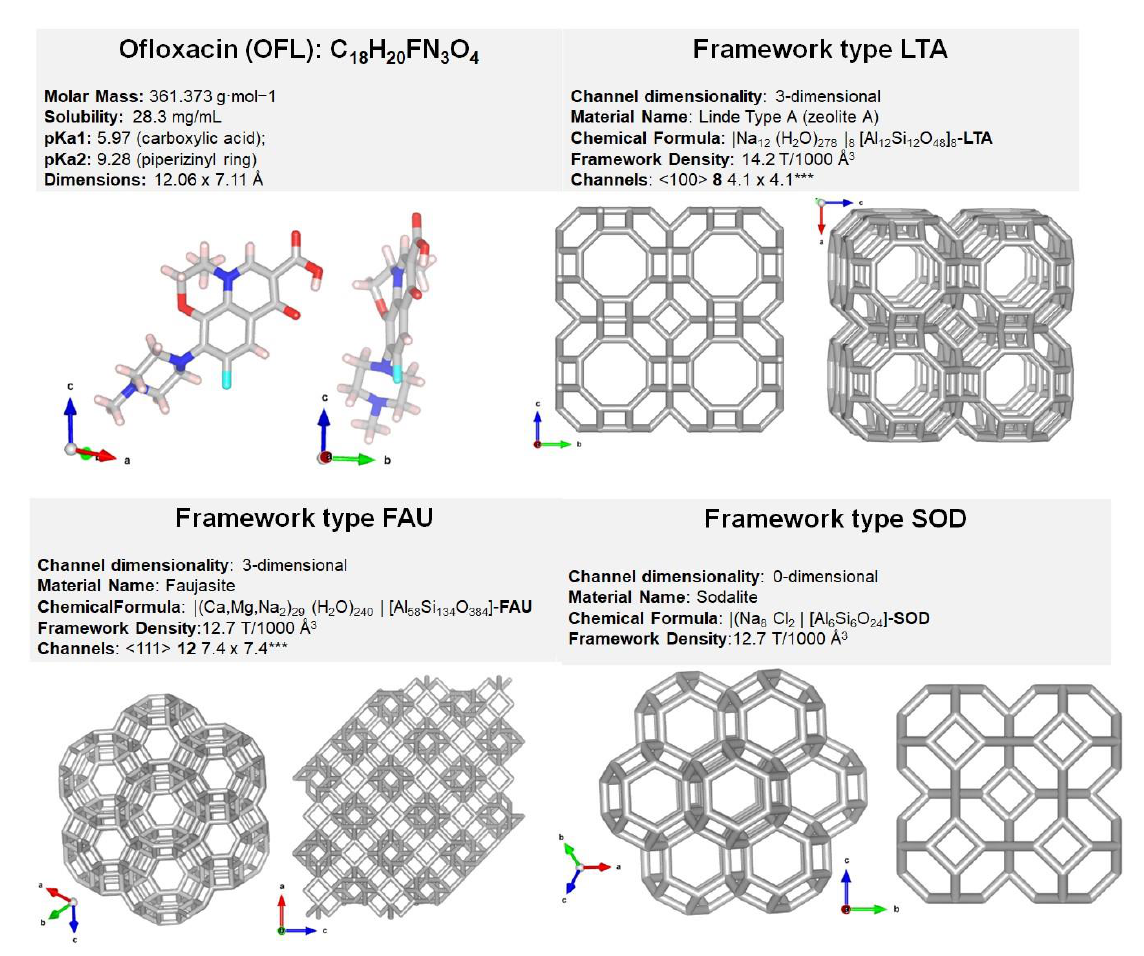
Figure 1. Structural and chemical characteristics of OFL antibiotic and zeolites formed. References for 3D structures [57–60], *** = Å .